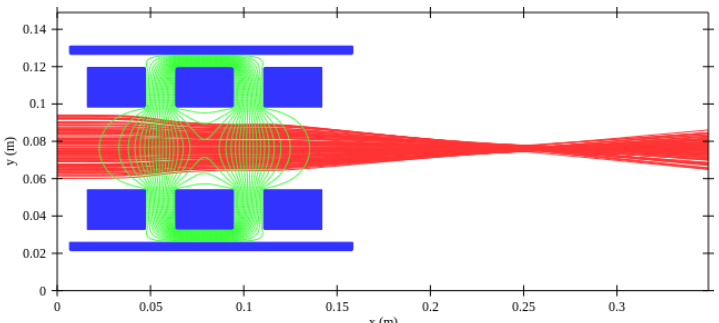
Figure 5. Focusing in a generic three-cylinder einzel lens. Blue solid objects are cross sections of the three cylindrical electrodes; red tracks are full trajectories of every 100th electron in the simulation; green contours represent equipotentials which are solved numerically.